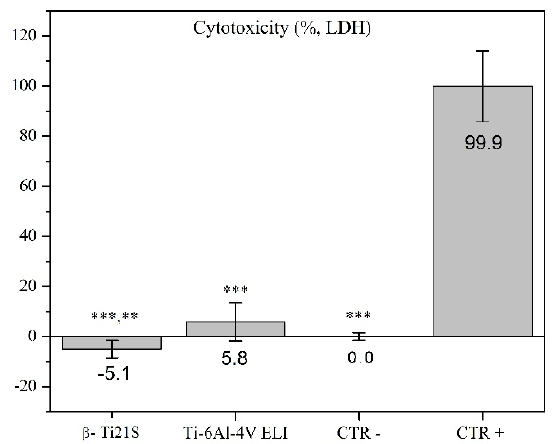
Figure 9. Viability results of the β -Ti21S (test), Ti–6Al–4V ELI (reference), and CTR − (cells without material) and CTR+ (cells with a cytotoxic substance) controls measured by Alamar Blue test and expressed as a percentage of CTR − . Red-dashed line represents 70% of negative control, which is a cut-off line between cytotoxic and non cytotoxic effects. Kruskal–Wallis followed by the Mann– Whitney U test: β -Ti21S, Ti–6Al–4V ELI, and CTR − vs. CTR+, *** p < 0.0005.